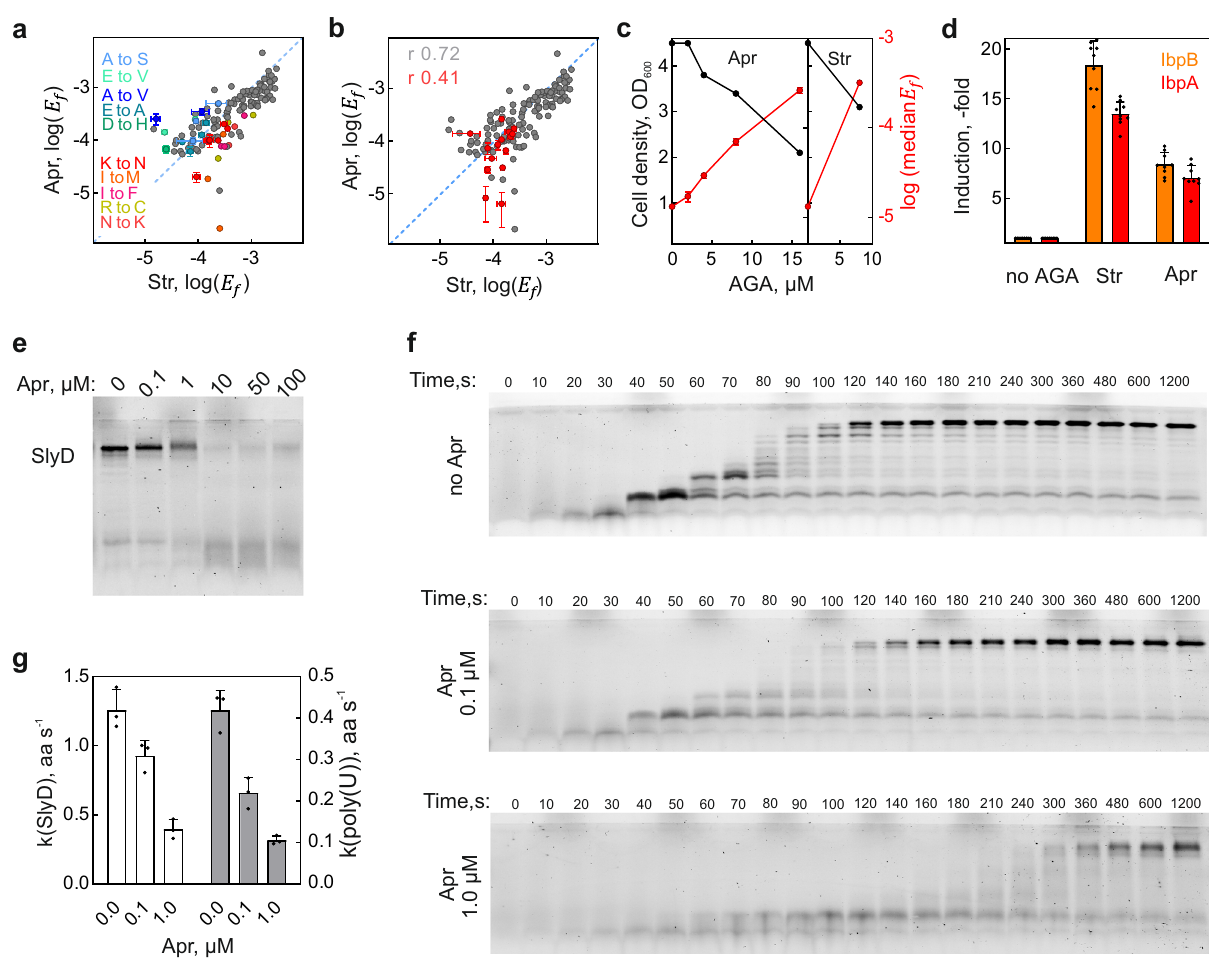
Fig. 3 Apramycin induces proteotoxic misreading and inhibits translocation. a Single amino acid substitutions induced by Apr and Str. Errors induced predominantly by Apr (16 µ M) are shown in cold colors; those induced by Str (8 µ M) in warm colors. Shown are means ± SD of three technical replicates ( n = 3). b Error clusters in Apr-treated cells (red) compared to single errors (gray). Shown are means± SD of three technical replicates ( n = 3). We note a better correlation for single errors (Pearson coef fi cient 0.72) than for error clusters (0.41), suggesting that the mechanisms that govern cluster formation are not identical to those for single errors and depend on the AGA used. c Growth defect and error load at increasing Apr concentrations. At growth- inhibitory concentration of Apr the median error frequency approaches that after Str treatment. Data from Supplementary Fig. 5b; Shown are means ± SD of three technical replicates ( n = 3). d Induction of the heat shock response. The chaperones IbpA/IbpB are signi fi cantly induced upon Apr (16 µ M) and Str (8 µ M) treatment as quanti fi ed by SRM. Shown are means ± SD of three technical replicates ( n = 3) calculated taking into account their individual peptide- based stoichiometries. e Products of the in-vitro translation of SlyD mRNA. Translation products are separated by SDS PAGE and detected using the fl uorescence of the N-terminal BODIPY-Met. f Time courses of in-vitro translation of SlyD mRNA at different Apr concentrations. Translation products were detected as in ( e ). g Rate of in-vitro translation (aa/s) at different Apr concentrations for SlyD mRNA (white bars) and poly(U) mRNA (gray bars). Shown are means ± SD of three technical replicates ( n = 3). See also Supplementary Fig. 5 and Source data fi